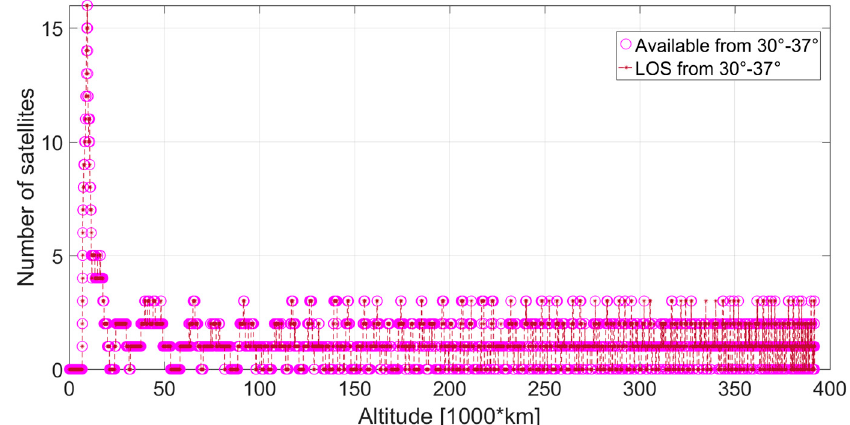
Figure 38. Visible satellites (in the line of sight (LOS)) and available satellites at the receiver’s position, for which the corresponding signal is transmitted at an angle between 30° and 37° from the transmitter’s boresight.